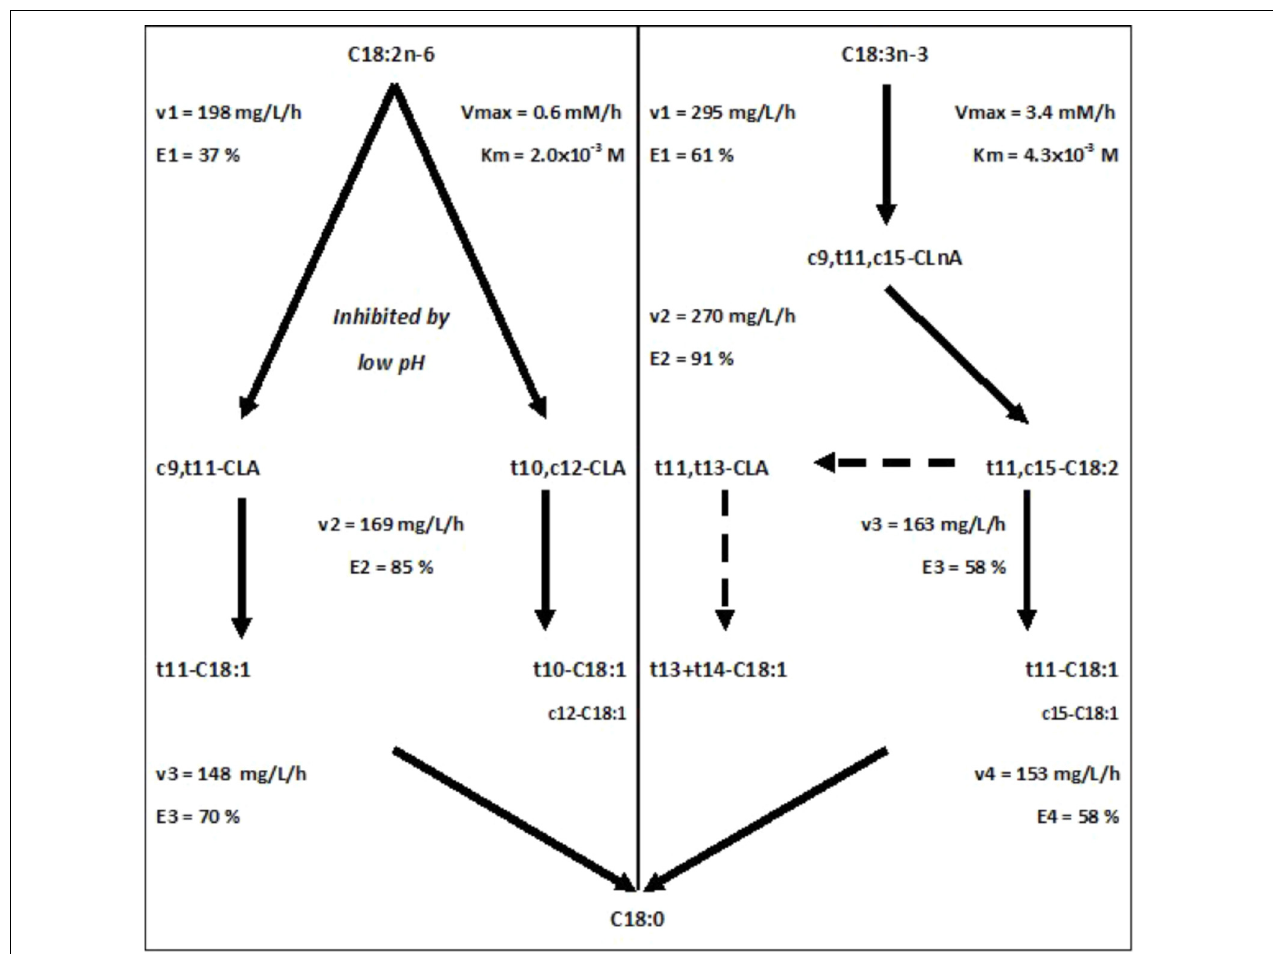
FIGURE 1 | Main pathways of kinetic parameters of biohydrogenation estimated from 1 h incubation studies with 1 mg of C18:2n-6 or C18:3n-3 in an enzymatic solution obtained from a cow’s ruminal content (solid line) and putative origin of t13 isomers (according to Fukuda et al., 2009; dotted line). The rate (v) and the efficiency (E) of the BH reactions were obtained from kinetics of disappearance of C18:2n-6 and C18:3n-3 reported in Experiments 1.1 and 2.1, respectively. K m and V max were estimated from Lineweaver–Burk representation with results of Experiments 1.2 and 2.2, using different concentrations of C18:2n-6 and C18:3n-3, respectively. Experiment 1.3 allowed the conclusion about pH